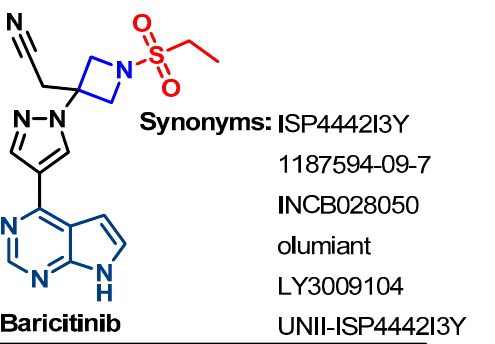
Figure 16. Chemical structure/name/synonyms of